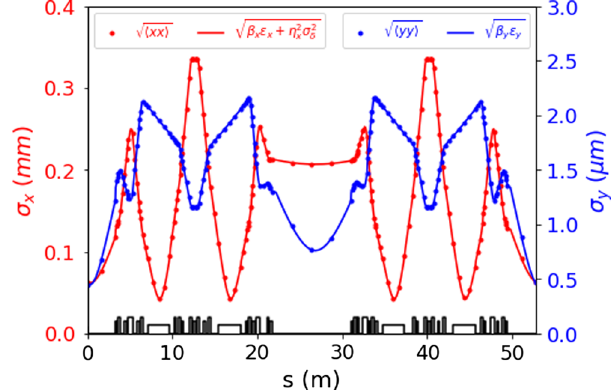
FIG. 1. NSLS-II DBA lattice magnet layout in a supercell. The beam sizes are represented with the 2nd moments in the SLIM analysis (dots) and the Courant-Snyder parameters (lines) for the uncoupled motion agrees with each other. Note that the vertical axes ’ scales and units for the horizontal (left) and vertical (right) beam sizes are